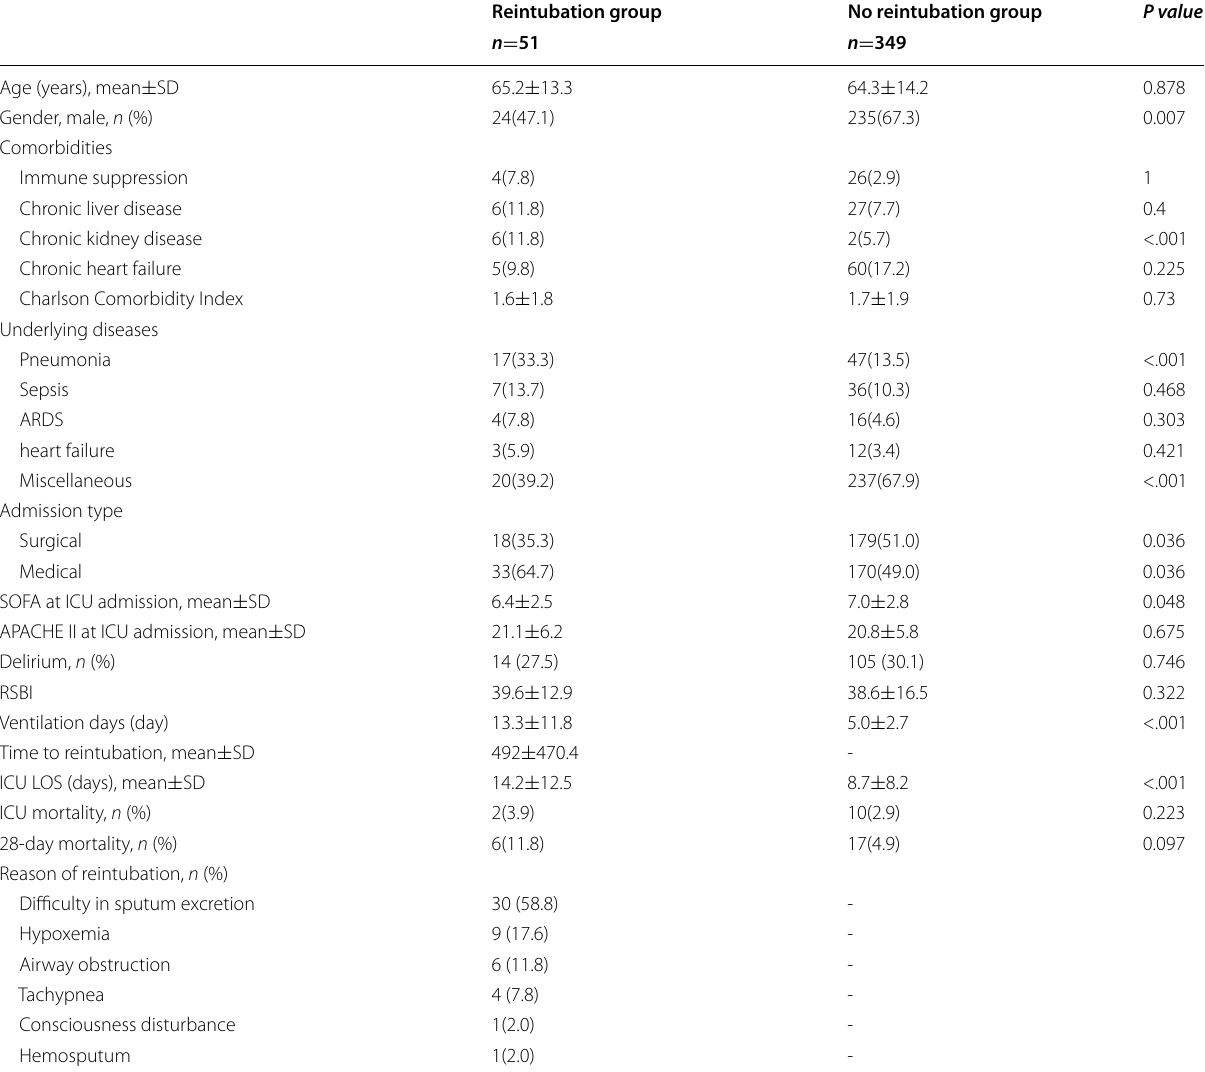
Table 2 Demographics of patients with and without reintubation